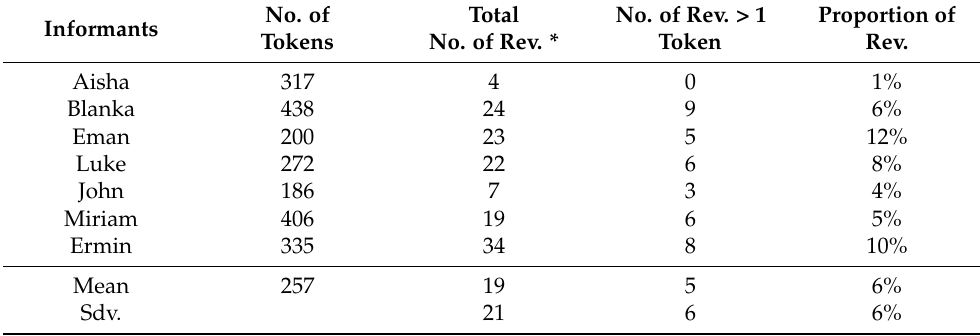
Table 3. Overview of text length and absolute number and proportion of revisions in students’ final texts from the second writing